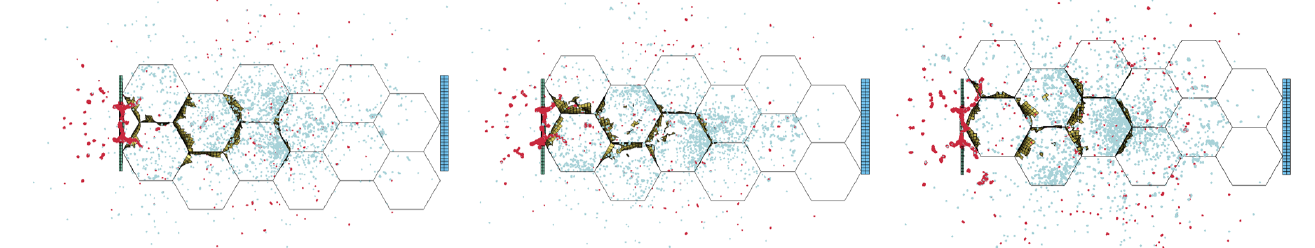
Figure 21. Comparison between varying points of impact: single edge (model L-SE, left ), mid-point (model L-MP, centre ) and double point (model L-DP, right